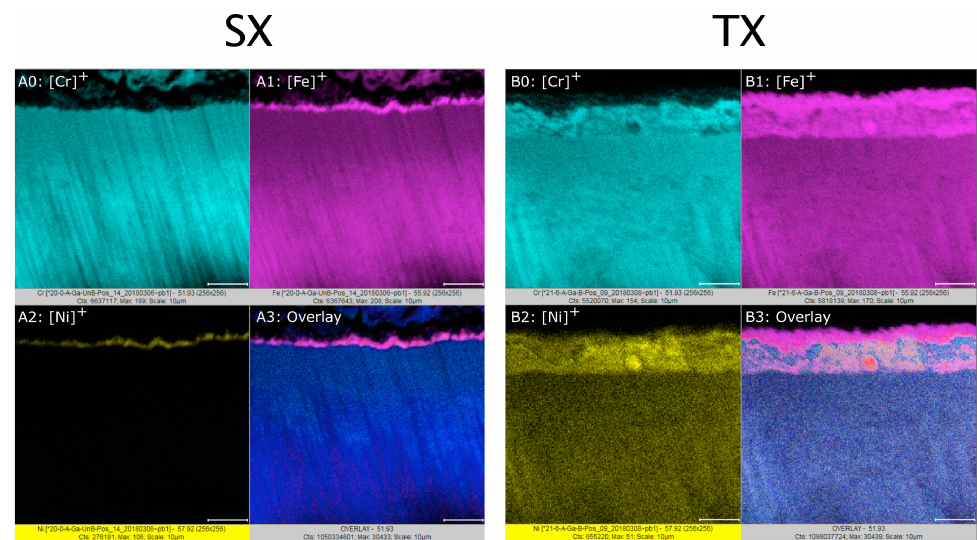
Figure 8. ToF-SIMS maps [Cr] + , [Fe] + , and [Ni] + and overlay. SX : activated by direct HCl gas exposure with the “double-HCl” process. TX : activated by gas from pyrolysis of 15 N 2 H 4 Cl. Both samples share a few features on these maps. Relative to the alloy core, the [Cr] + maps of both have a lower intensity in the outermost portion of the RL-T, while the [Fe] + and [Ni] + maps show higher